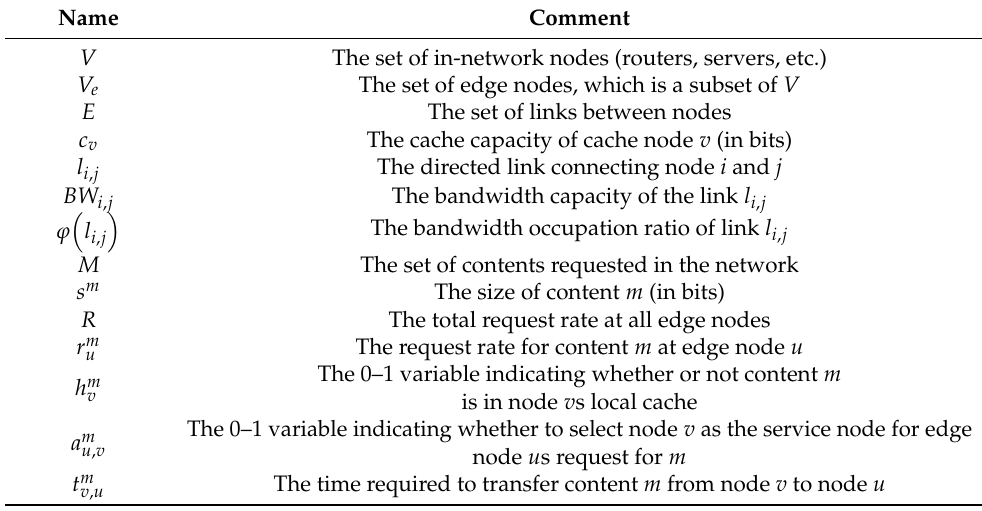
Table 1. Summary of the